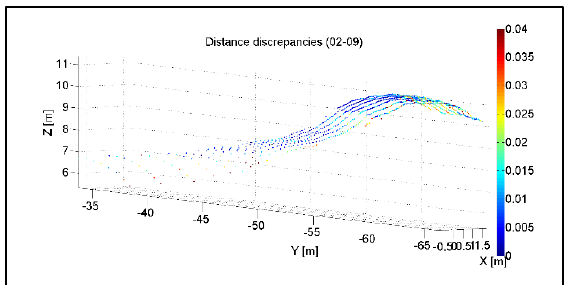
Figure 6. Distance discrepancies between Dec. 2 nd and 9 th with colour bar changing from 0 to 4